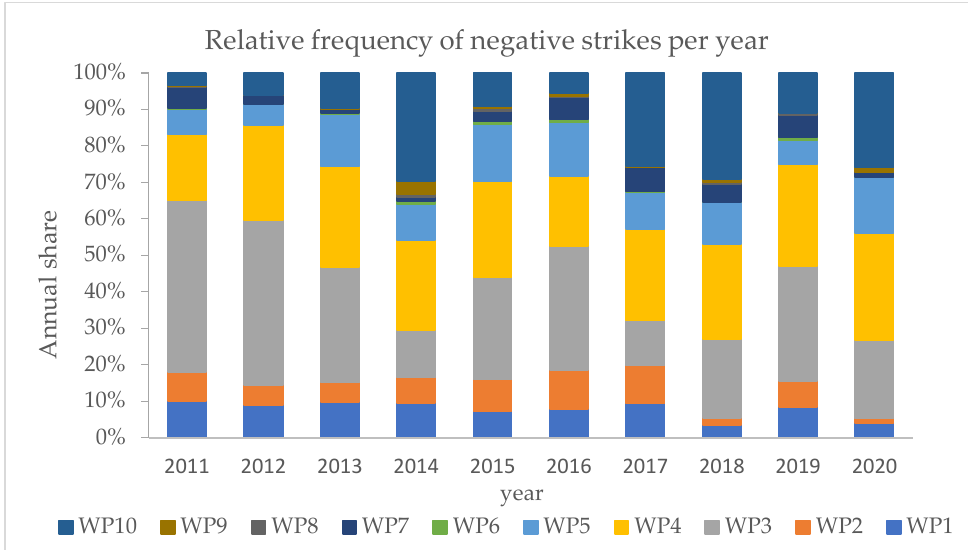
Figure 3. Relative share of the annual negative strikes of each wind park as a percentage of the total negative strikes recorded per year.